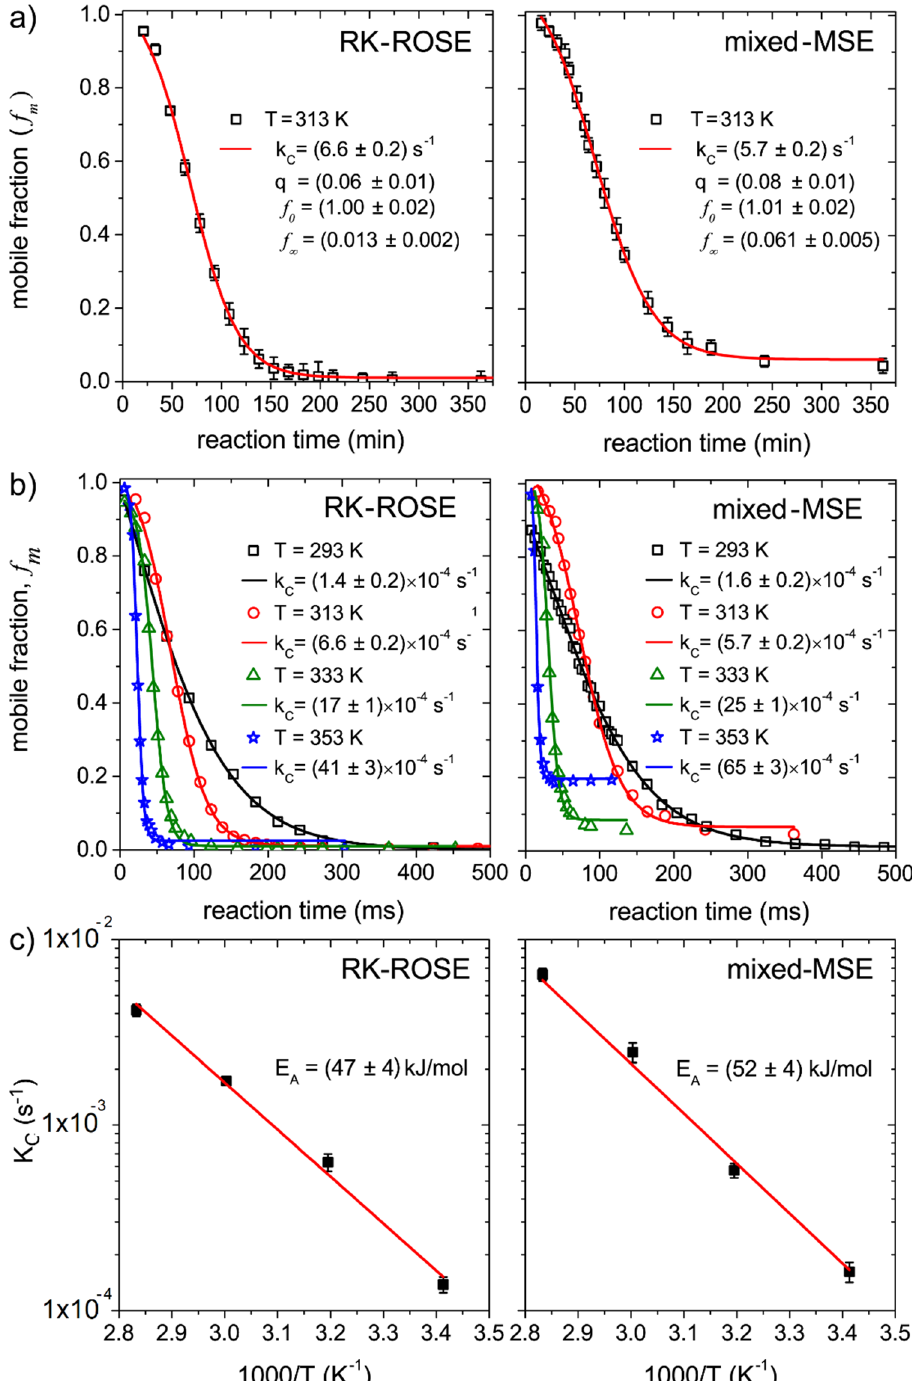
Figure 3. ( a ) Mobile fractions, as function of the reaction time during the epoxy cure, obtained from the deconvolution of signals acquired by the mixed-MSE (right) and RK ROSE (left) pulse sequences at 313 K. ( b ) Same as in ( a ) for 293 K, 313 K, 333 K and 353 K. ( c ) Arrhenius plot of the k c values estimated from the fits shown in ( b ). The error bars were omitted in ( b ), but they are in the same order as those shown in ( a ).The meaning of k c , q , f 0 , f ∞ are describe in the main